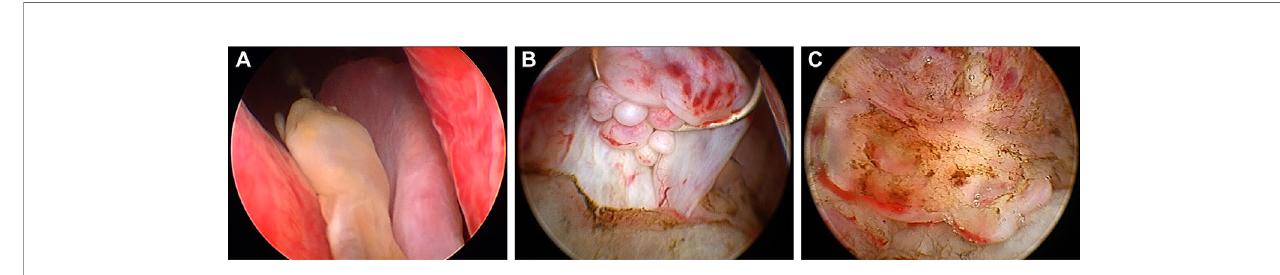
FIGURE 4 | Urethrocystoscopic performance of the tumor. (A) Two cord-like neoplasm located at the apex of the prostate and extended from the right of verumontanum to the neck of the bladder. (B) A multi-chamber cystic mass surrounded a region of the prostate gland that lacked blood supply. (C) Mucous substance can be observed on the